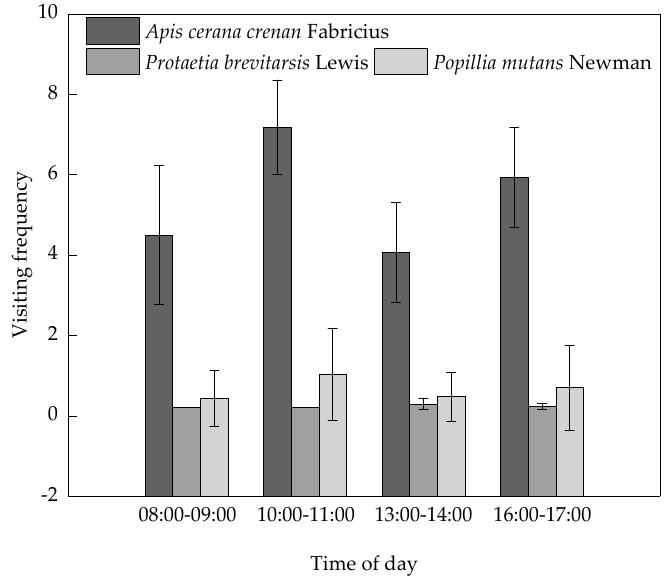
Figure 6. Pollinator visitation frequency for Schima superba (S.E.).